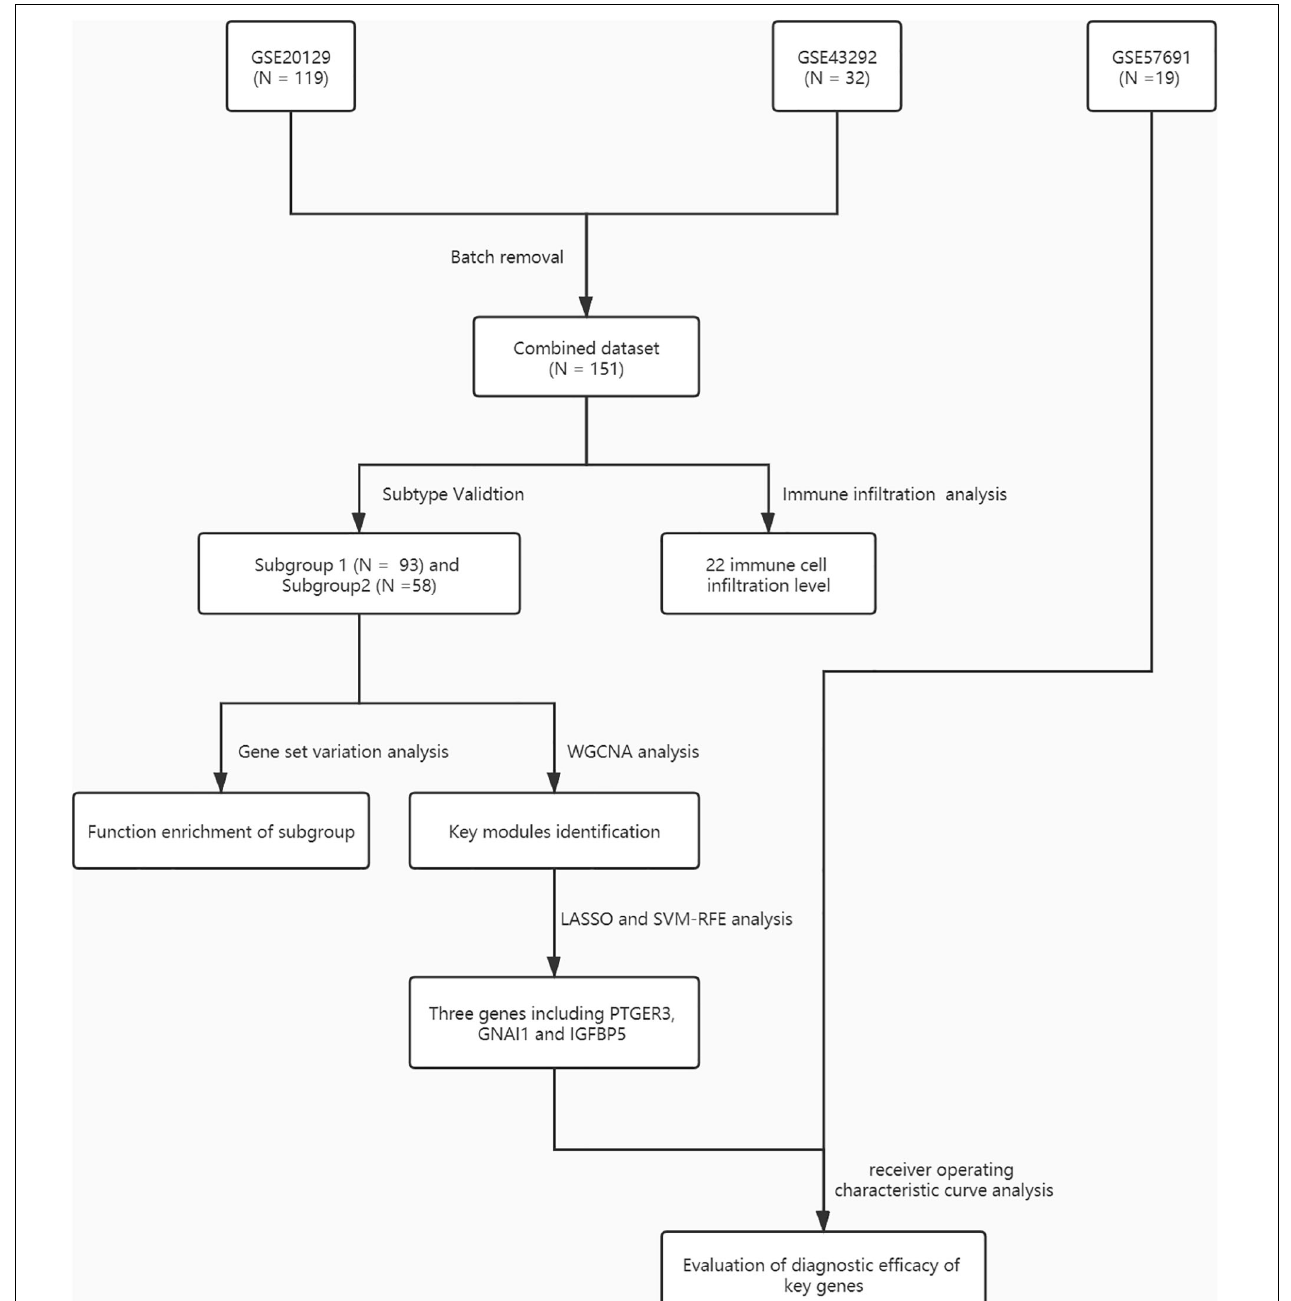
FIGURE 1 | A flowchart for the analysis procedure to identify potential molecular subtypes and key genes in this study.